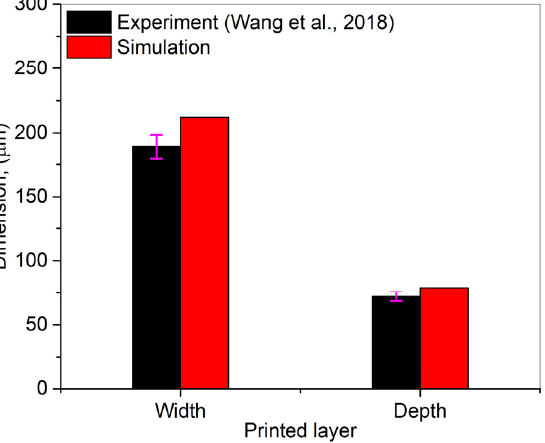
Figure 10. A comparison between experimental [43] and simulation width and depth of a single layer for Co–Cr alloy.